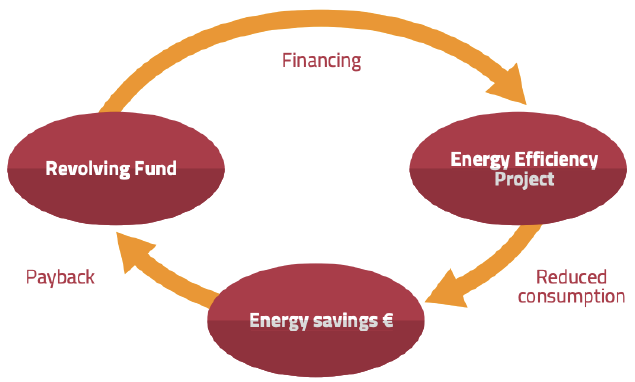
Figure 7. Basic structure of a revolving fund (Source: [44]) .